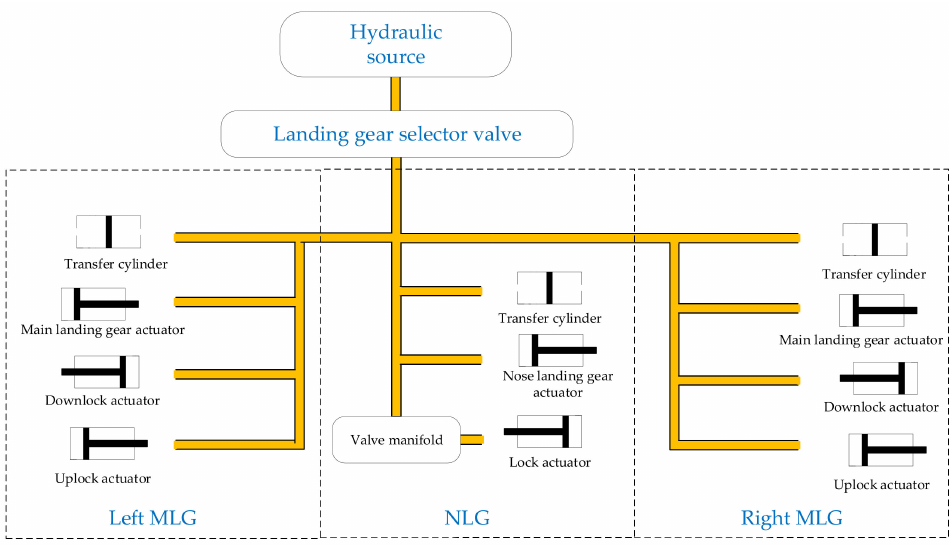
Figure 2. Basic structure of landing gear R/E hydraulic system.